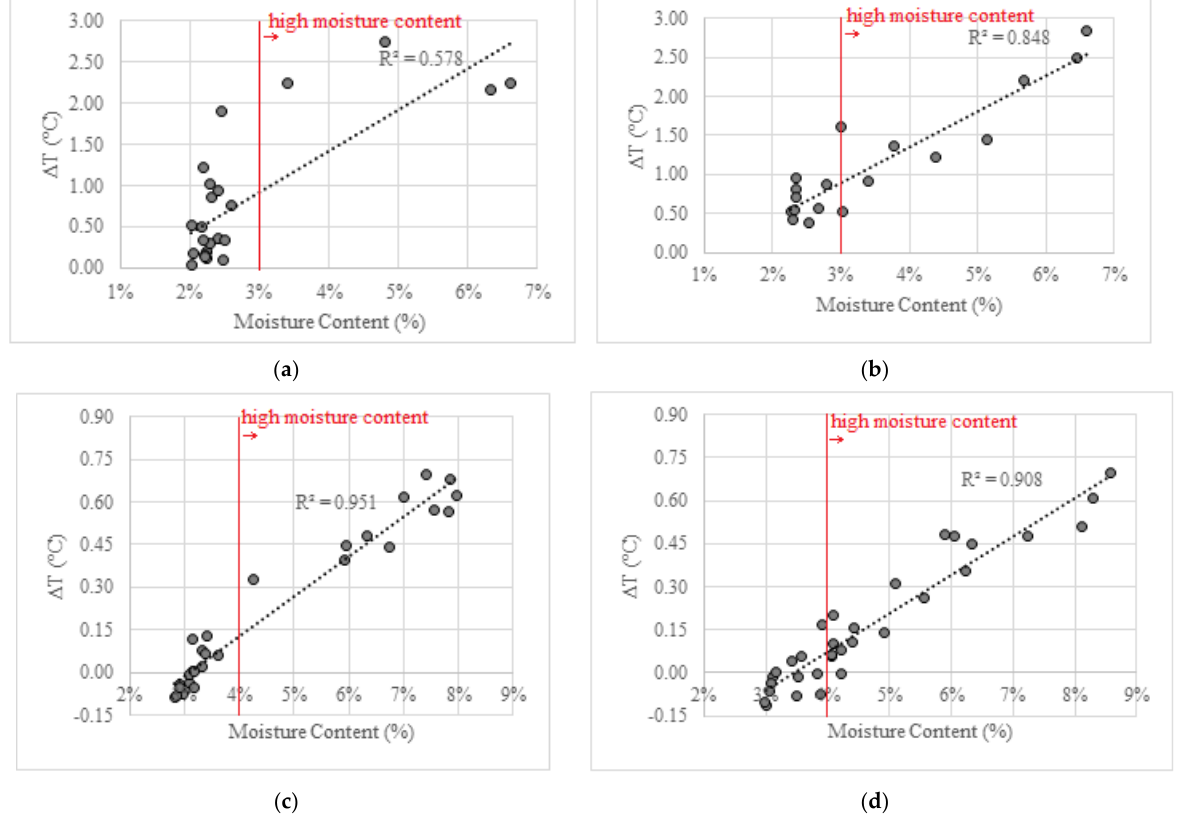
Figure 12. Scatter plot of the ∆ T and the moisture content: ( a ) humidification—hot chamber; ( b ) drying—hot chamber; ( c ) humidification—cold chamber; ( d ) drying—cold chamber.